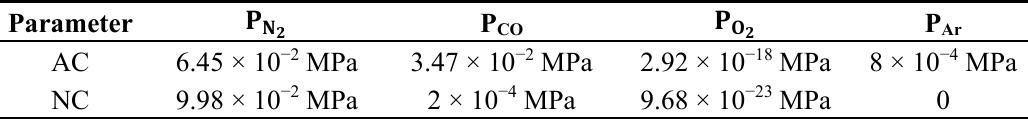
Table 2. The equilibrium gas partial pressure of AC and NC at 1800